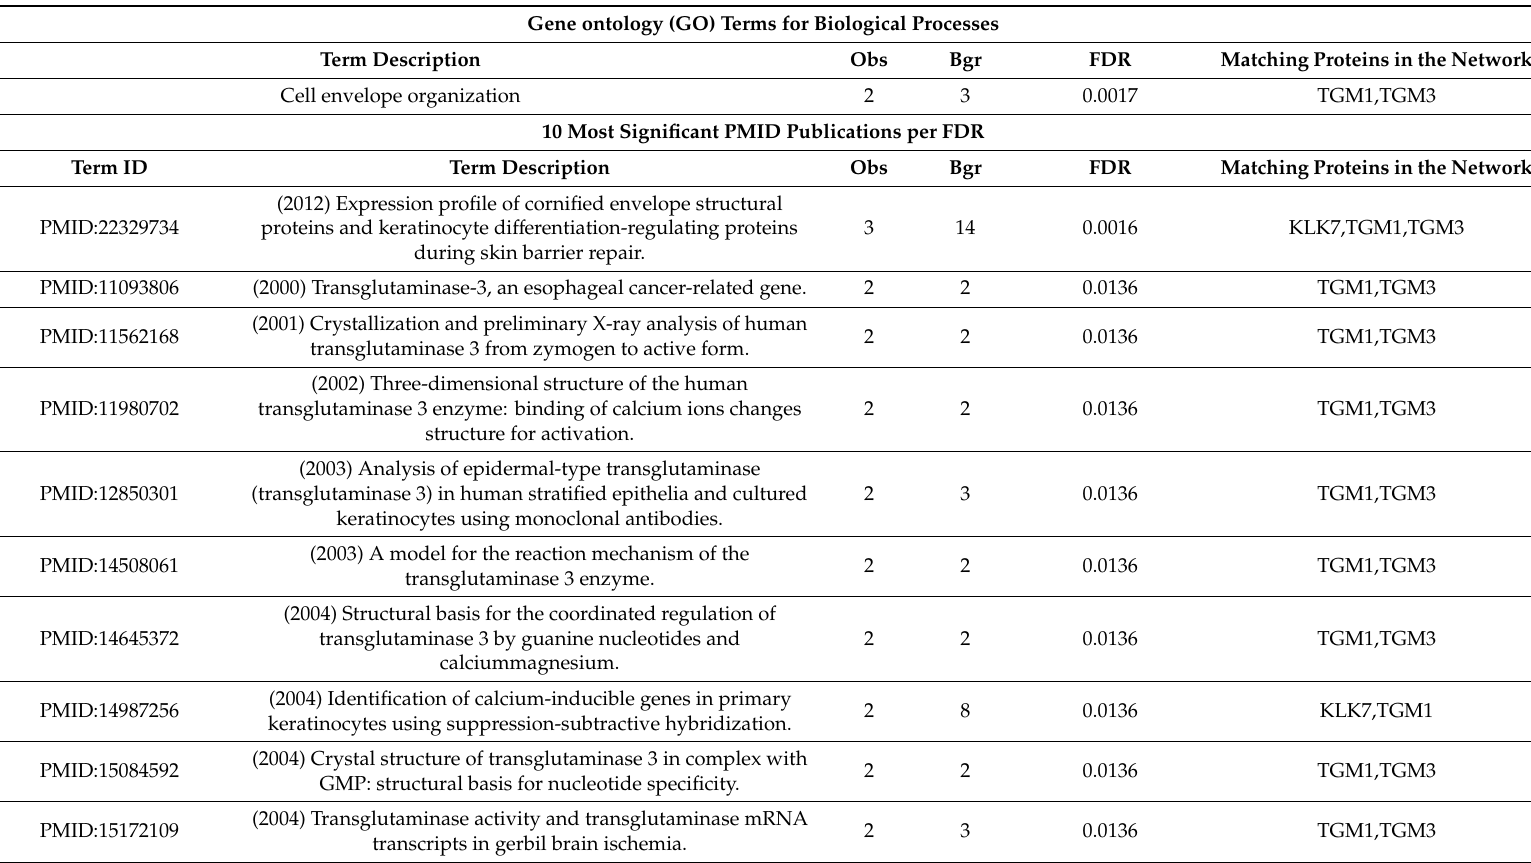
Table 9. Biological processes and PMIDs for the EV total unique proteins in the HIV group for the HIV vs. HIV + A β